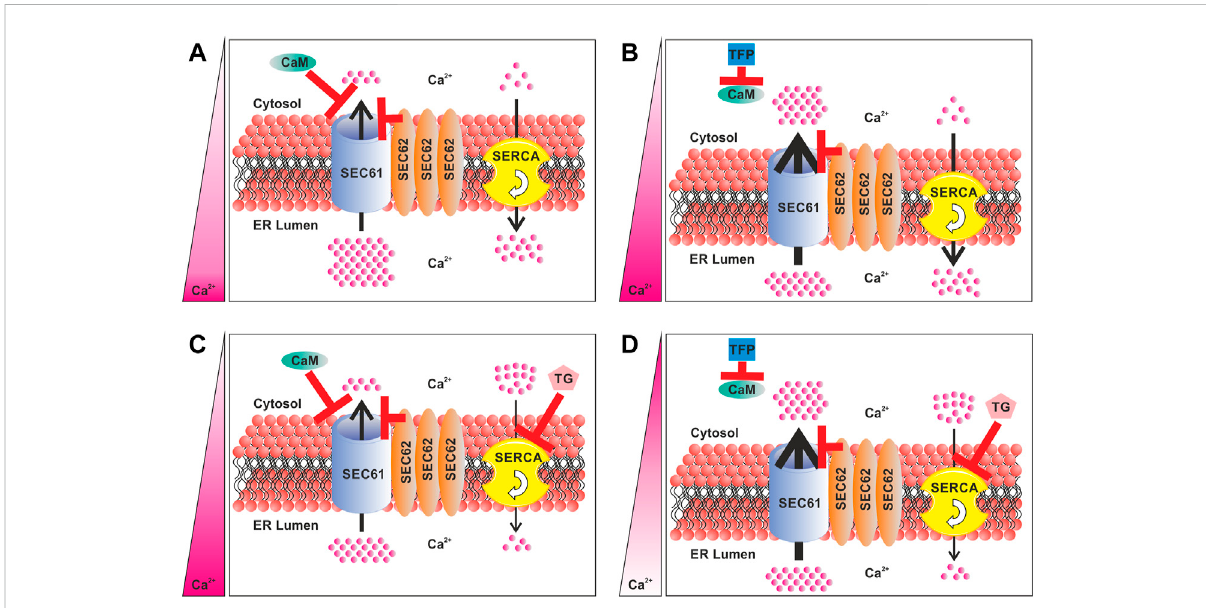
FIGURE 1 ComponentsoftheCa 2+ homeostasisregulationoftheERin SEC62 overexpressingcancercells. (A) Roleof SEC62 ampli fi cationinregulationof the Ca 2+ ef fl ux. (B) Differences in the Ca 2+ ef fl ux and resulting Ca 2+ homeostasis under TFP treatmentby the inhibition of CaM. (C) Differences in the Ca 2+ ef fl ux and resulting Ca 2+ homeostasis under TG treatment by inhibition of the SERCA. (D) Differences in the Ca 2+ ef fl ux and resulting Ca 2+ homeostasis under a consecutive treatment of TFP and TG by blocking CaM and through the inhibition of the SERCA. The red bars indicate an inhibitionand/orchannelclosure.ThicknessofthearrowsindicatesthestrengthofCa 2+ ef fl uxandthe fl owrateoftheSERCA.Thepinkbarontheleft indicates the Ca 2+ balance between the ER and the cytosol. A dark pink color indicates a high Ca 2+ level, whereas white color indicates a low Ca 2+ level. CaM, calmodulin; TFP, tri fl uoperazine; TG, thapsigargin; SERCA, sarcoplasmic/endoplasmic reticulum Ca 2+